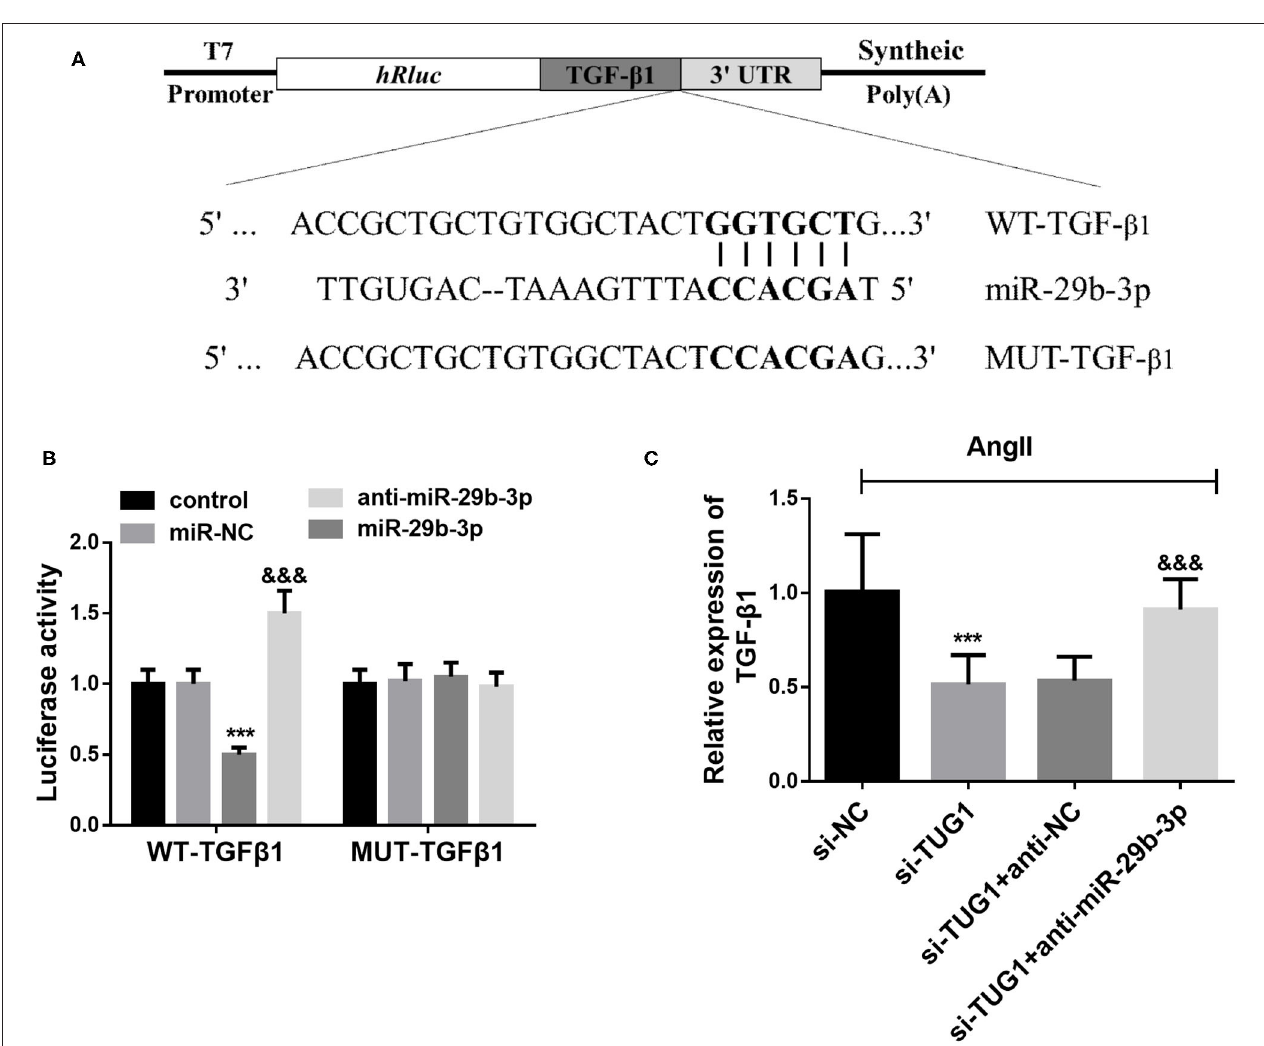
FIGURE 5 | TGF- β 1 is a direct target gene of miR-29b-3p. (A) Complementary sequences between miR-29b-3p and the 3 ′ UTR of TGF- β 1 according to the Target Scan analysis. (B) miR-29b-3p overexpression reduced the luciferase activity in TGF- β 1-WT transfected cells, whereas miR-29b-3p downregulation strengthened the luciferase activity. For TGF- β 1-MUT transfected cells. MiR-29b-3p expression did not influence the luciferase activity (*** p < 0.001). (C) Downregulation of miR-29b-3p reversed the inhibiting effect of TUG1 knockdown on TGF- β 1 expression in AF cell models (*** p < 0.001, compared with the si-NC group; &&& p < 0.001, compared with the si-TUG1